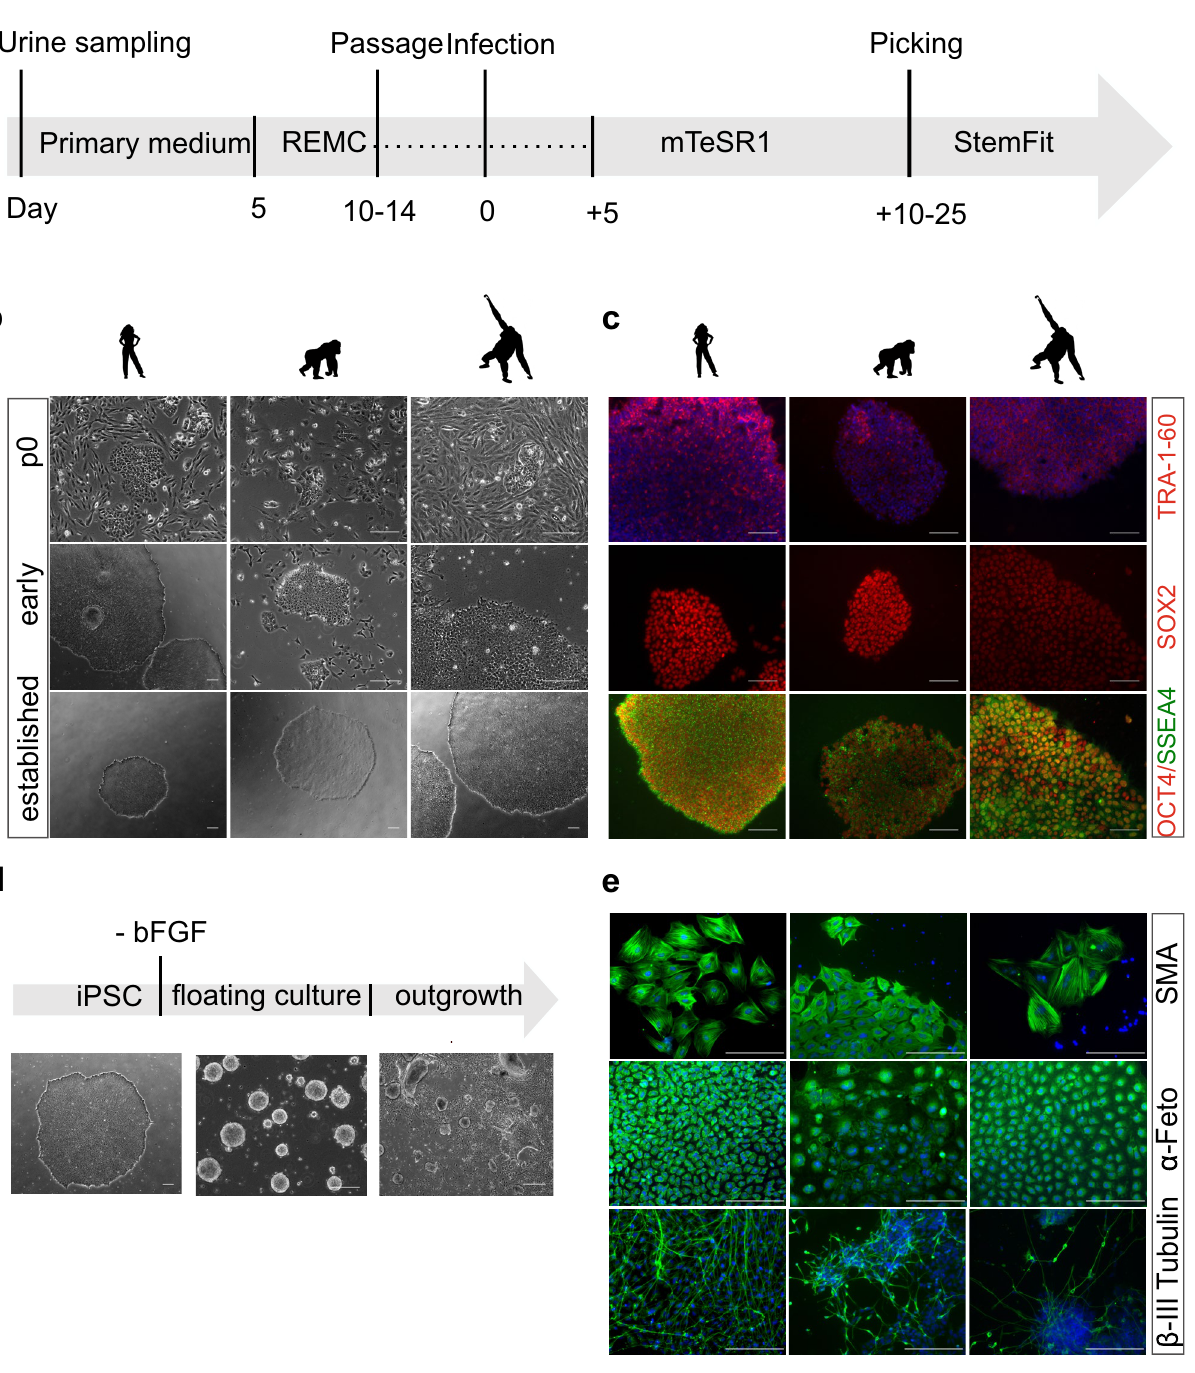
Figure 4. Generation and characterization of primate iPSCs. ( a ) Workflow for reprogramming of primate urinary cells. Urine collection and cell seeding is carried out in primary medium, then after 5 days changed to REMC medium, and only passaged for the first time after 10–14 days. When the cells reach confluency reprogramming is induced and after 5 days the medium is changed to mTeSR1. Once the reprogrammed cells are ready to be picked, the cells are seeded in StemFit medium. REMC renal epithelial mesenchymal cell medium. ( b ) Cell morphology of the three species is comparable before (p0), during (p1–3) and after reprogramming (~ p5). Scale bar represents 400 µm. ( c ) Immunofluorescence analysis of pluripotency associated proteins at passage 10–15: TRA-1-60, SSEA4, OCT4 and SOX2. Nuclei were counterstained with DAPI. Scale bars represent 200 µm. ( d ) Differentiation potency into the three germ layers. iPSC colony before differentiation, after 8 days of floating culture and after 8 days of attached culture. Scale bar represents 400 µm. ( e ) Immunofluorescence analyses of ectoderm (β-III Tubulin), mesoderm (α-SMA) and endoderm markers (α-Feto) after EB outgrowth. Nuclei were counterstained with DAPI. Scale bars represent 400 μm. See also Supplementary Figure